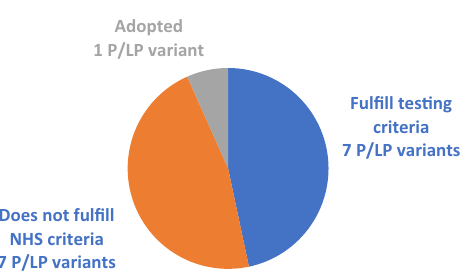
Figure 5. A detailed look at the patients with pathogenic / likely pathogenic variants: did they fulfil NHS eligibility criteria? In this study, the same number of P/LP variants were detected in patients who were eligible for genetic testing and those who were not.